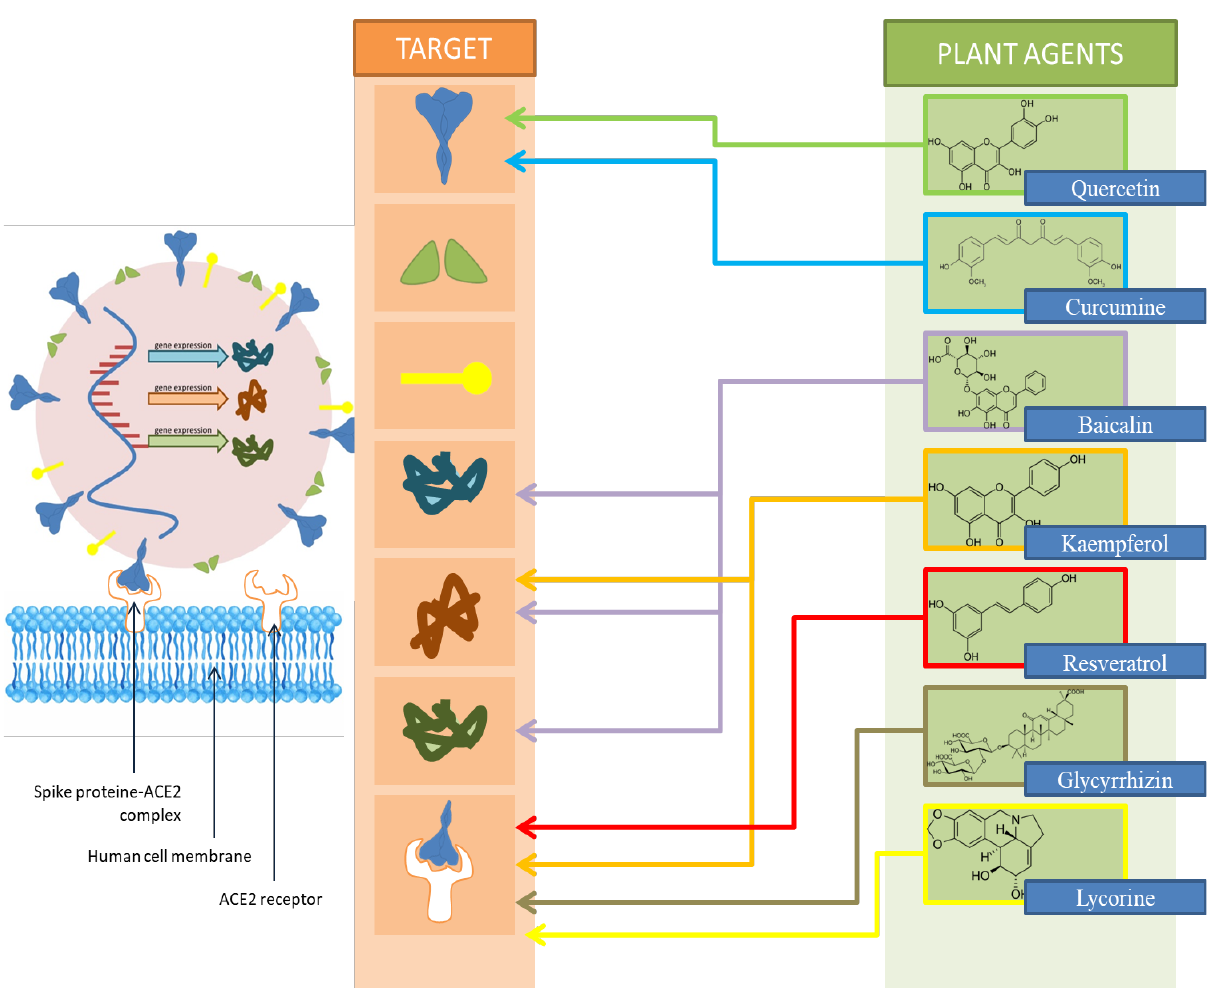
Figure 2. Schematic representation of the site of action of the listed phytochemicals.